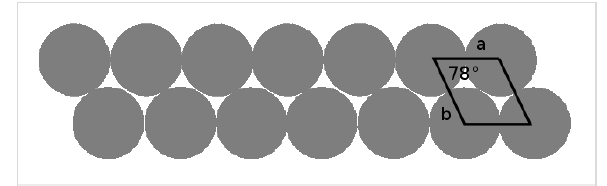
Figure 2: Monoclinic solid-state packing arrangement of the imogolite